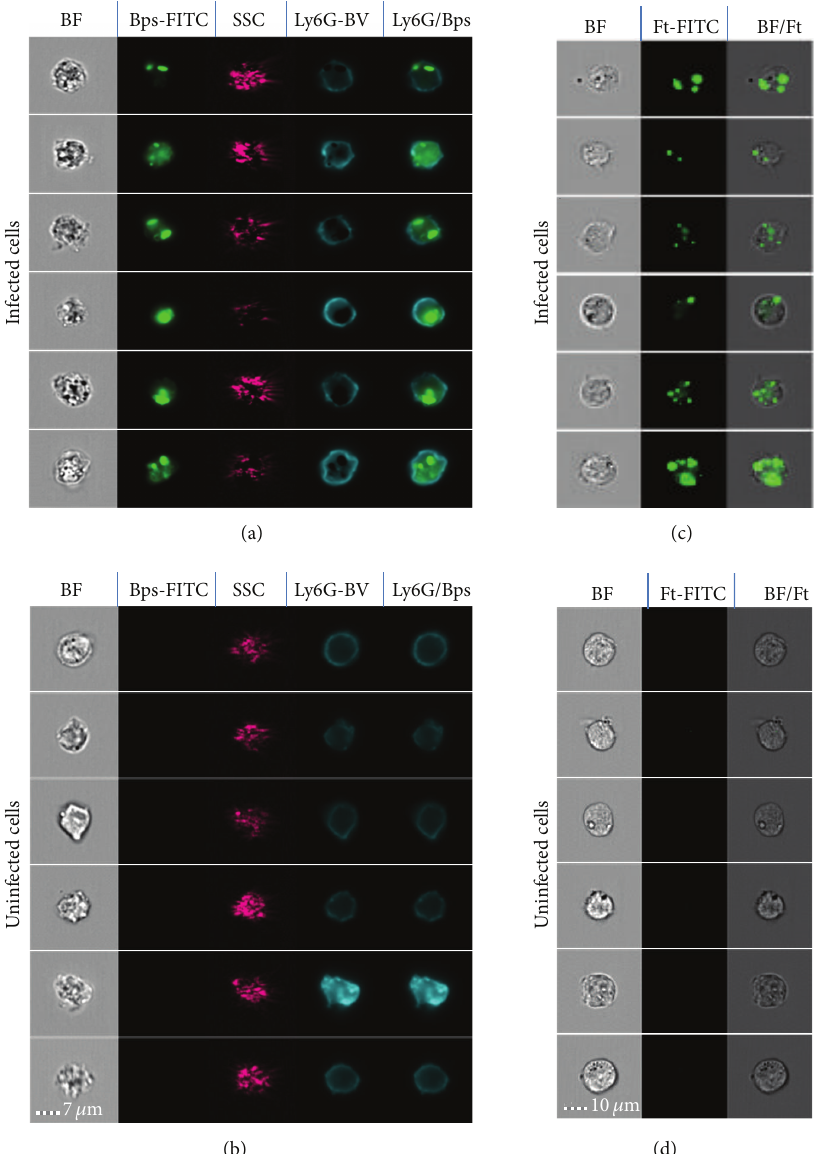
Figure 1: ImageStreamX Mk1 imaging depicting intracellular infection of ex vivo and in vitro cells. (a) Infected and (b) uninfected ex vivo lung cells stained with fluorescently labelled antibodies specific for Burkholderia pseudomallei (Bps) and the neutrophil marker Ly6G. A composite (overlayed) fluorescence image shows intracellular Bps inside neutrophils (Ly6G/Bps). Mouse macrophage cell line (P388D.1) infected (c) in vitro with F. tularensis SCHU S4 (Ft) or uninfected controls (d). Each Image series shows 6 representative cells from one sample . SSC = Side Scatter; BF = Brightfield; FITC = Fluorescein Isothiocyanate; BV = Brilliant